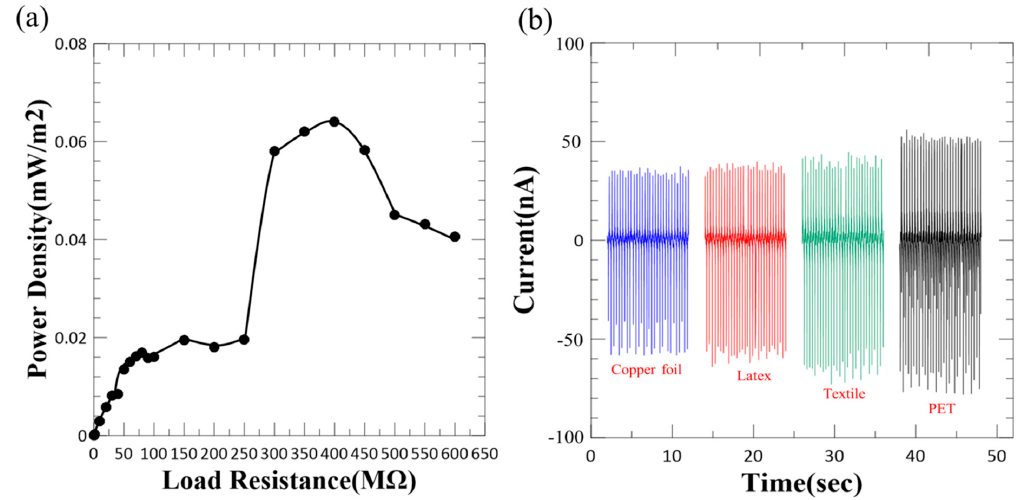
Figure 7. ( a ) The dependence of the WTENG power density on the resistance of the external load. ( b ) Current output of WTENG on contact with different freestanding triboelectric layers.